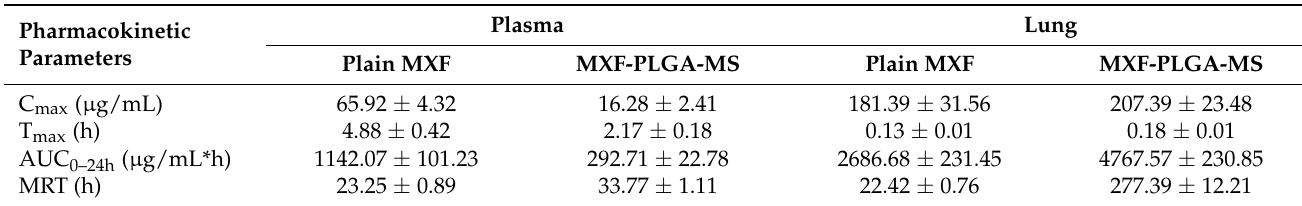
Table 4. Pharmacokinetic parameters following pulmonary administration of either plain MXF or MXF-loaded microspheres.